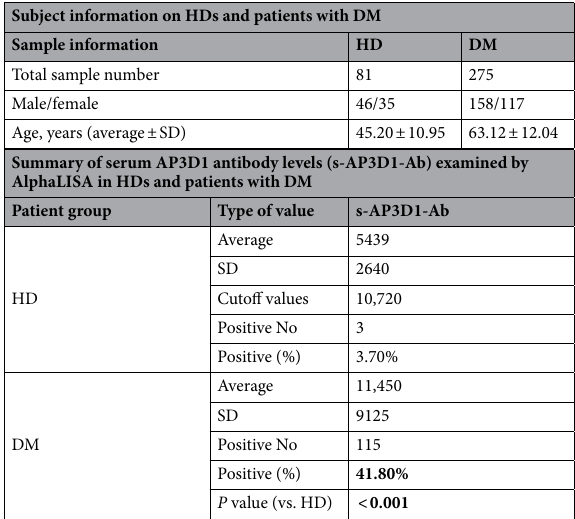
Table 2. Comparing the anti-AP3D1 antibody levels between HDs and patients with diabetes mellitus (DM). The upper panel indicates the number of total samples, samples from male and female participants, and ages (average ± SD). The lower panel summarizes the s-AP3D1-Ab levels examined using AlphaLISA. Numbers are as shown in Table 1; P -values of < 0.05 and positive rates of > 10% are marked in bold font. The plots for these data are shown in Fig.